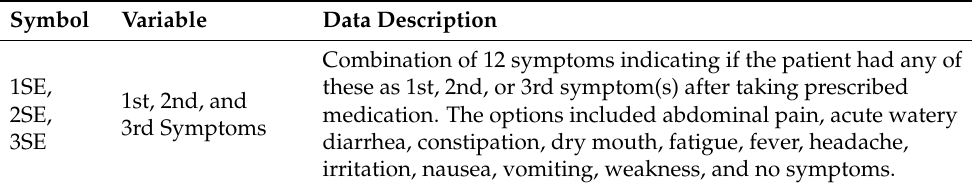
Table 3. Data variables on patient’s post-medication symptoms.